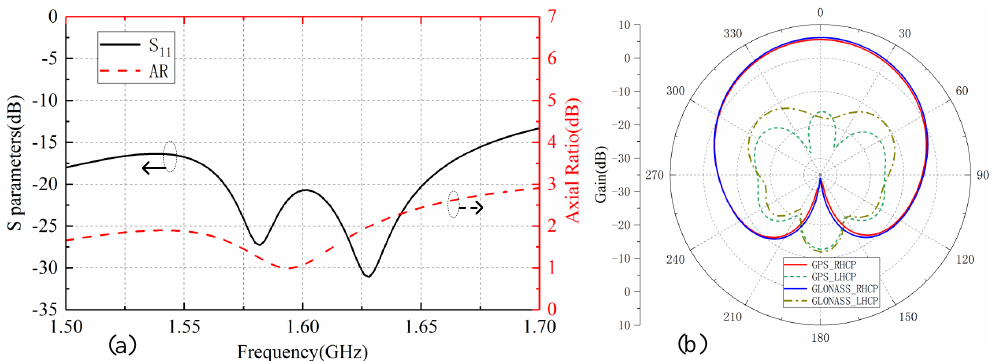
Figure 3. The ( a ) S parameters and axial ratio and ( b ) radiation patterns of the GPS/GLONASS antenna in the array.